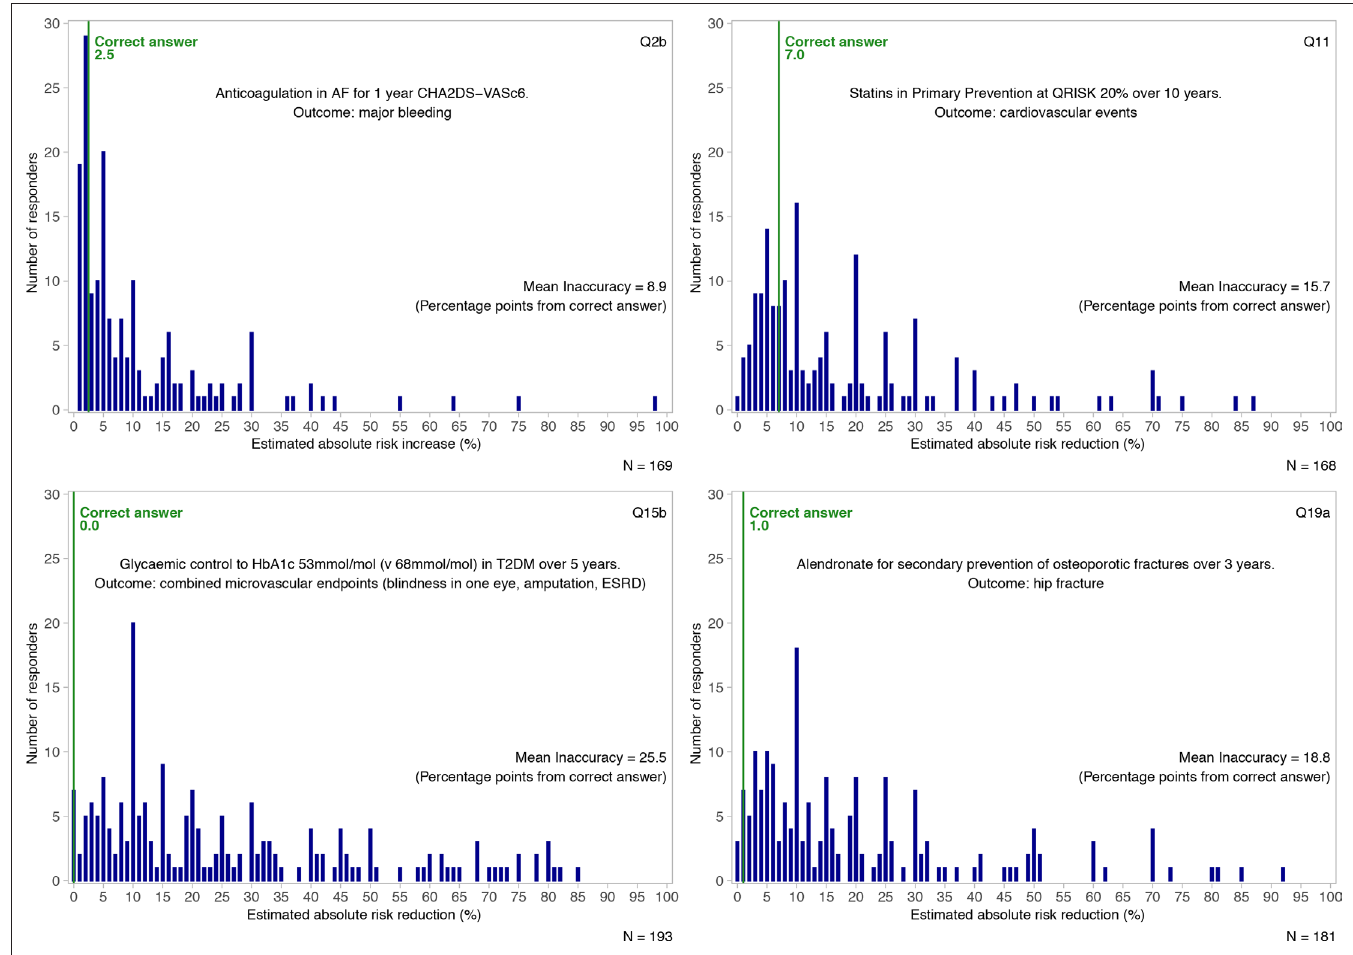
Figure 2 Responses to four survey